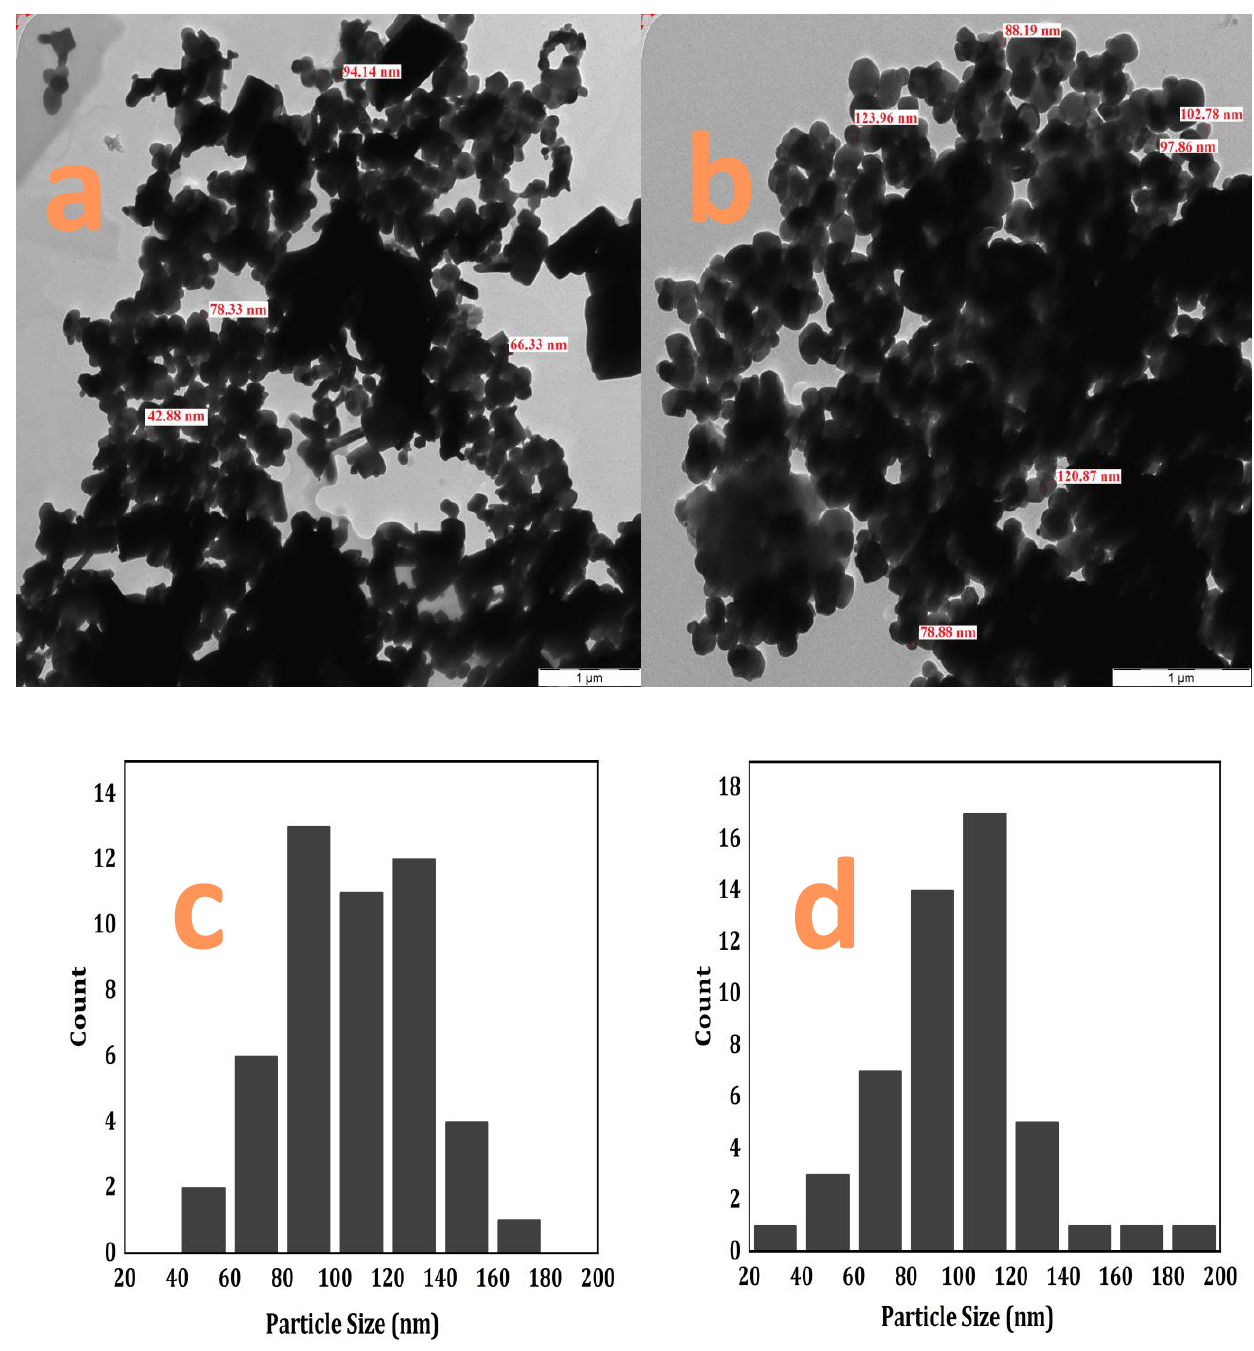
Figure 2. TEM images of ZnO ( a ) and ZnO/GO ( b ). Particle size distribution histograms for ZnO ( c ) and ( d ).